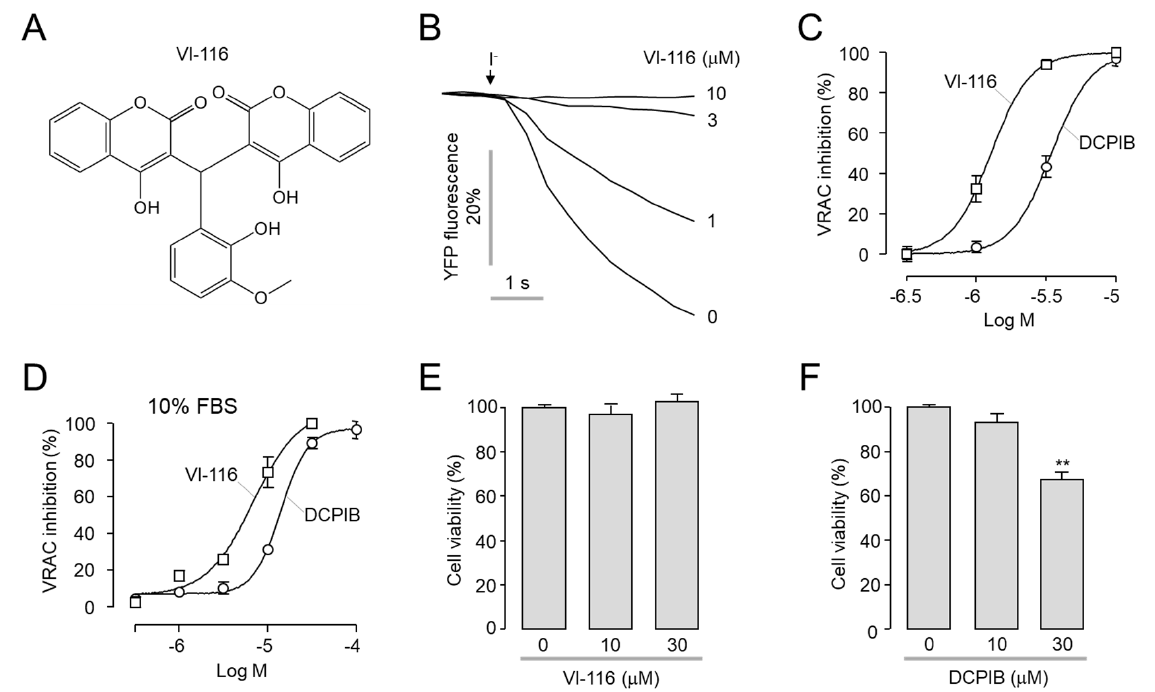
Figure 3. Effect of VI-116 and DCPIB on VRAC activity and cell viability. ( A ) Structure of VI-116. ( B ) Representative YFP fluorescence traces. The inhibitory effects of VI-116 on VRAC activity were determined using YFP fluorescence assay in LN215 cells. VRAC was activated by application of hypertonic solution for 5 min. ( C ) Summary of VRAC dose-response (mean ± S.E., n = 4). ( D ) Summary of VRAC dose − response with 10% FBS (mean ± S.E., n = 4). ( E , F ) NIH3T3 cells were treated with the indicated concentrations of VI-116 or DCPIB for 24 h and cell viability was measured by MTT assay (mean ± S.E., n = 4), ** p < 0.01.